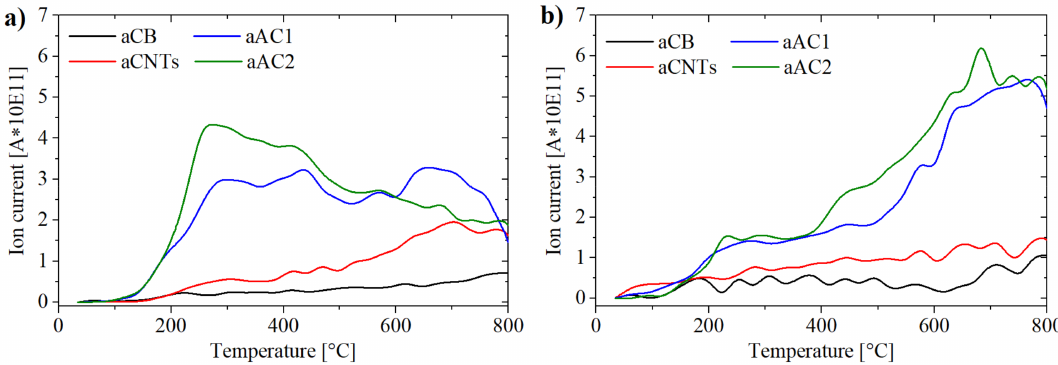
Figure 7. Thermal Programmed Desorption (TPD) measurement from the different carbon materials: detected amounts of ( a ) CO 2 and ( b ) CO (10 ◦ C min − 1 ; 20 mL He min − 1